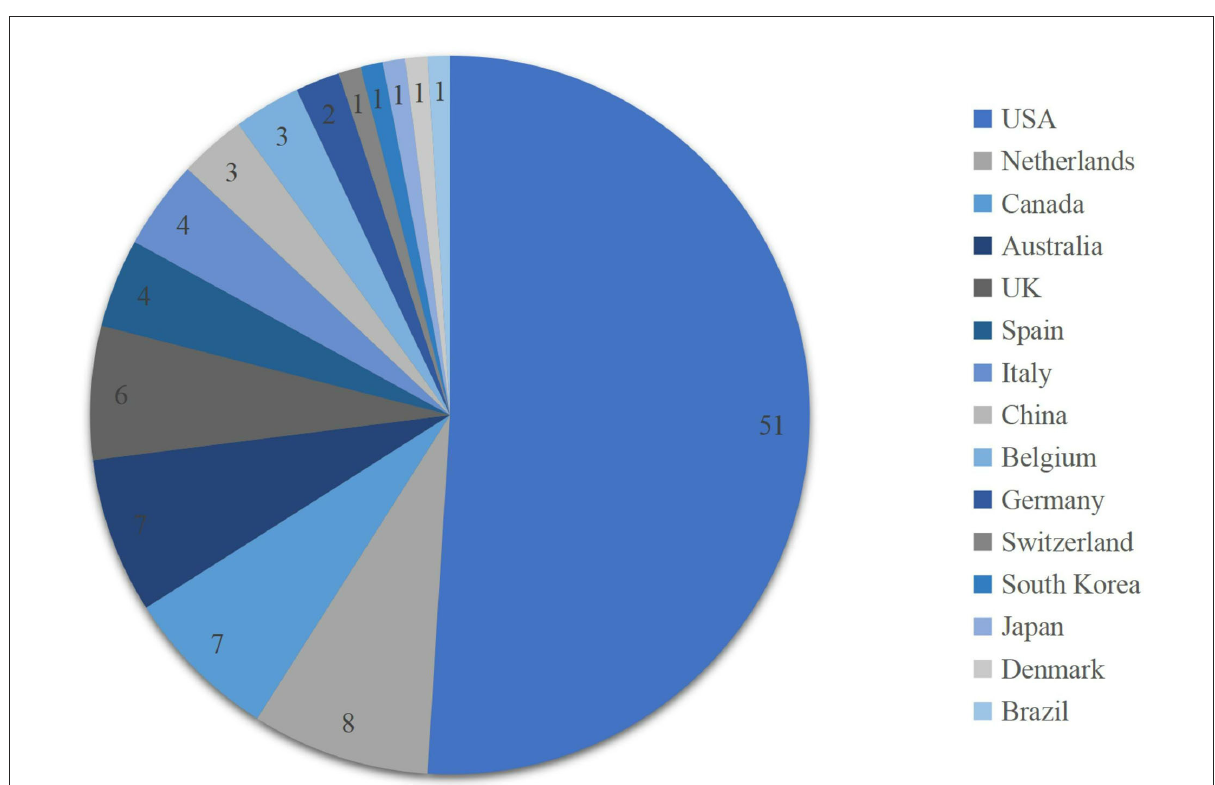
FIGURE6 Original countries of the top 100